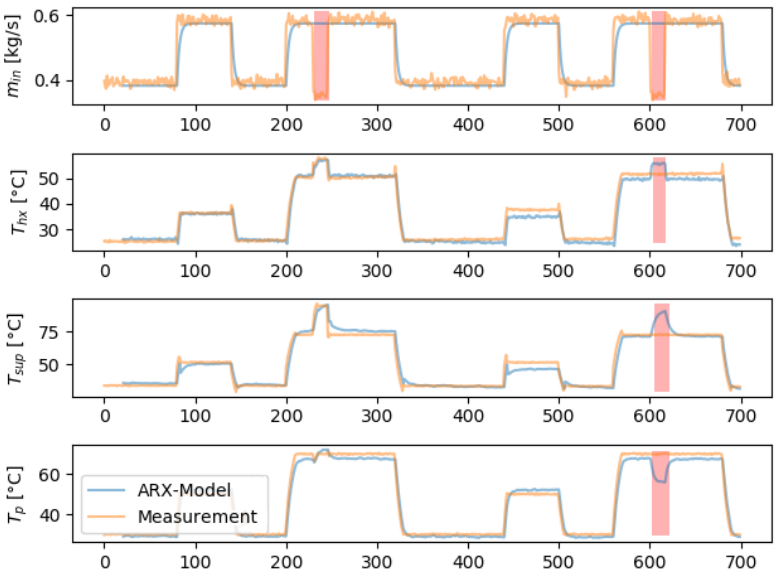
Figure 13. Anomalies detected by the Sensor Anomaly Detection